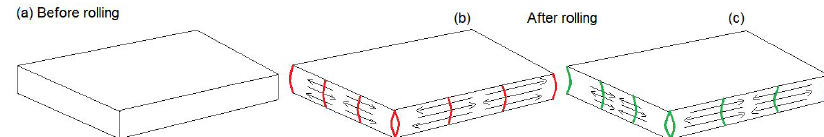
Figure 5. Characteristic aspects of the edges of rolled sheets: (a) before rolling and (b, c) possibilities after